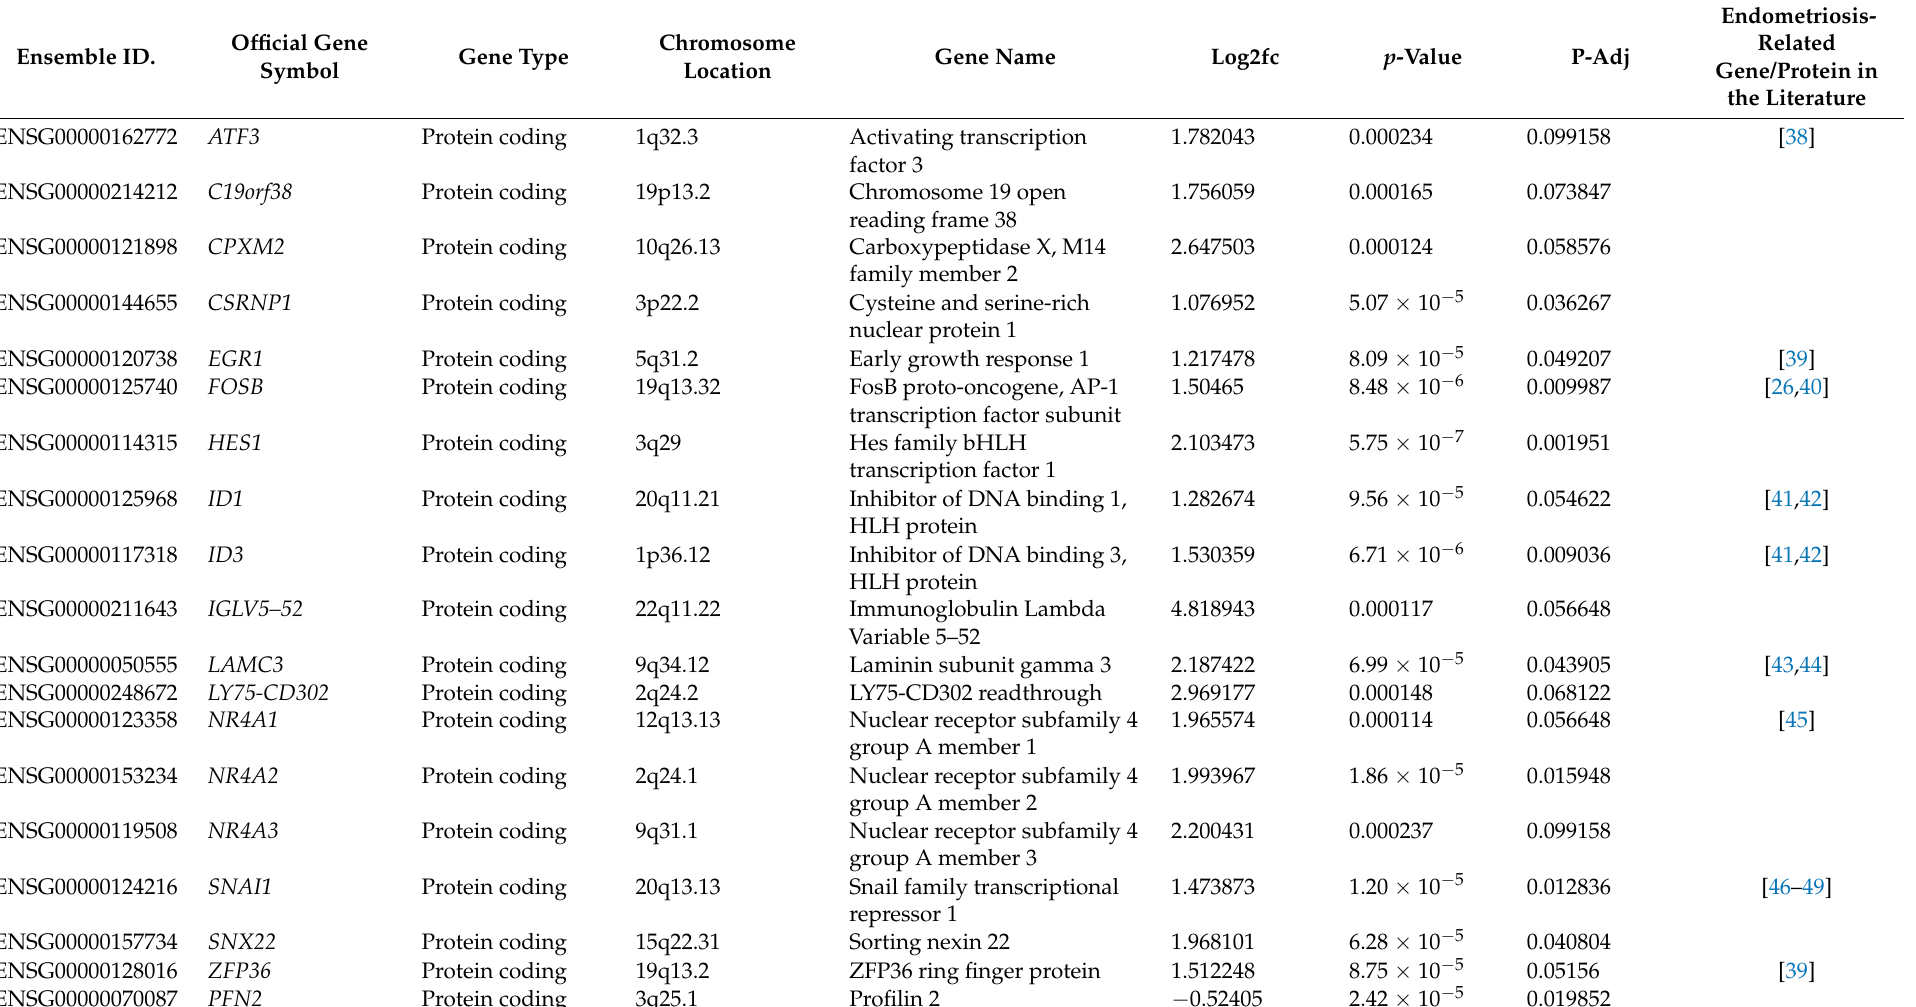
Table 1. Differential expression of coding genes in endometriosis MenSC and endometriosis-related genes/proteins in the literature.